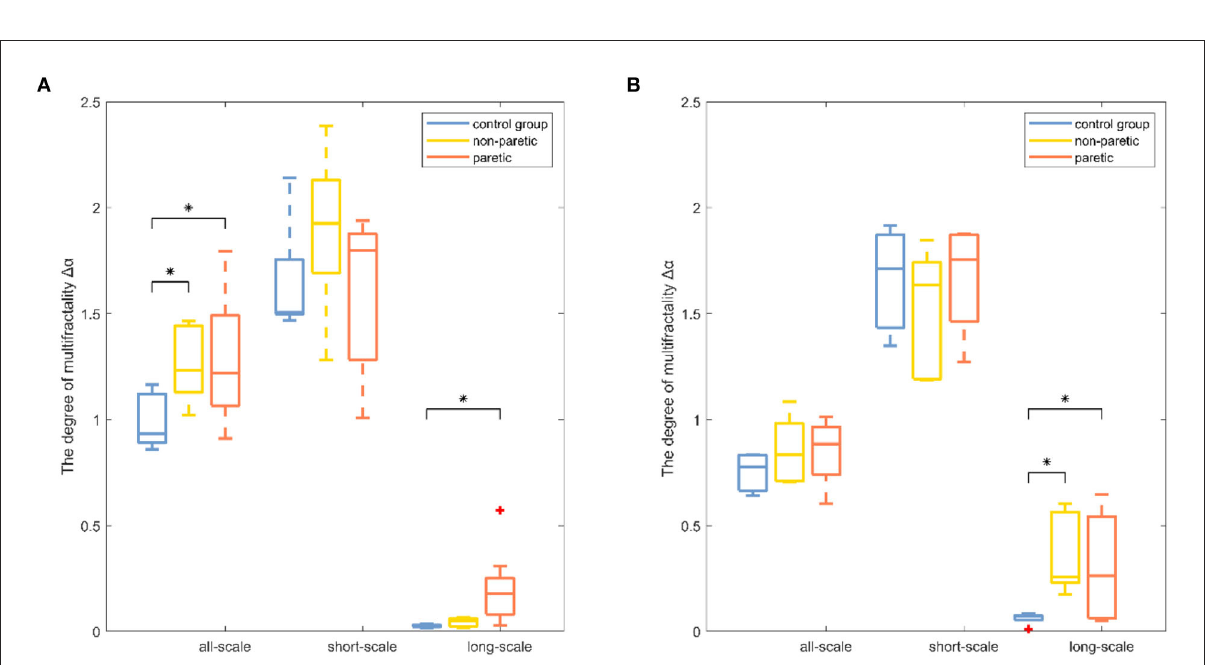
FIGURE5 Boxplots of the degree of multifractality results among the paretic limbs and the non-paretic limbs of a patient with stroke and the control group under three conditions (all-scale; short-scale; long-scale) during treadmill-walking tasks. Boxplots show the quartiles, the medians, and the ranges of the individual results. Outliers are indicated with + signs. * Indicates statistically significant difference at a p − value < 0.05 .